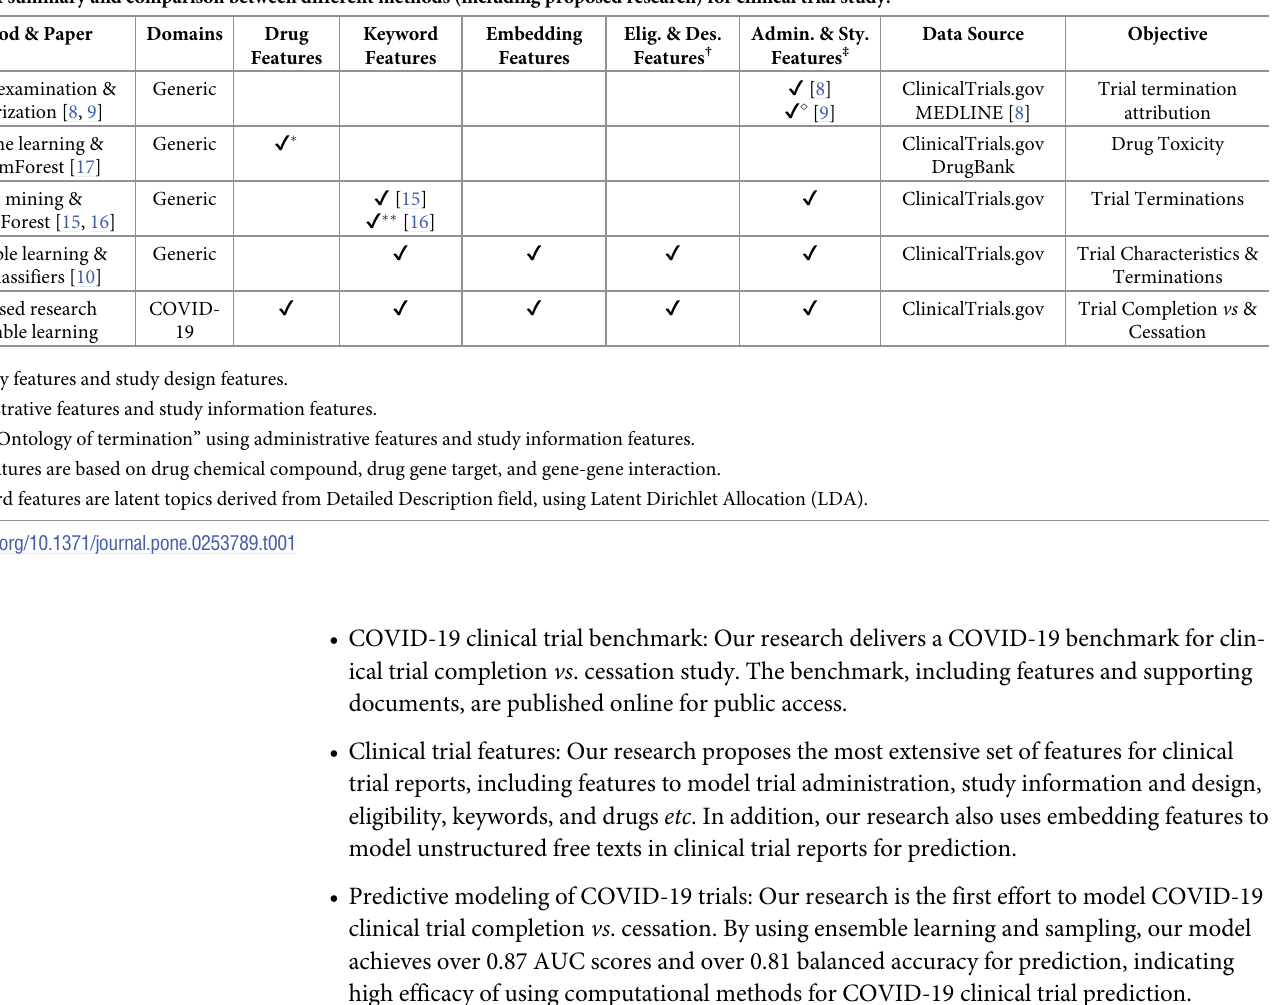
Table 1. A summary and comparison between different methods (including proposed research) for clinical trial